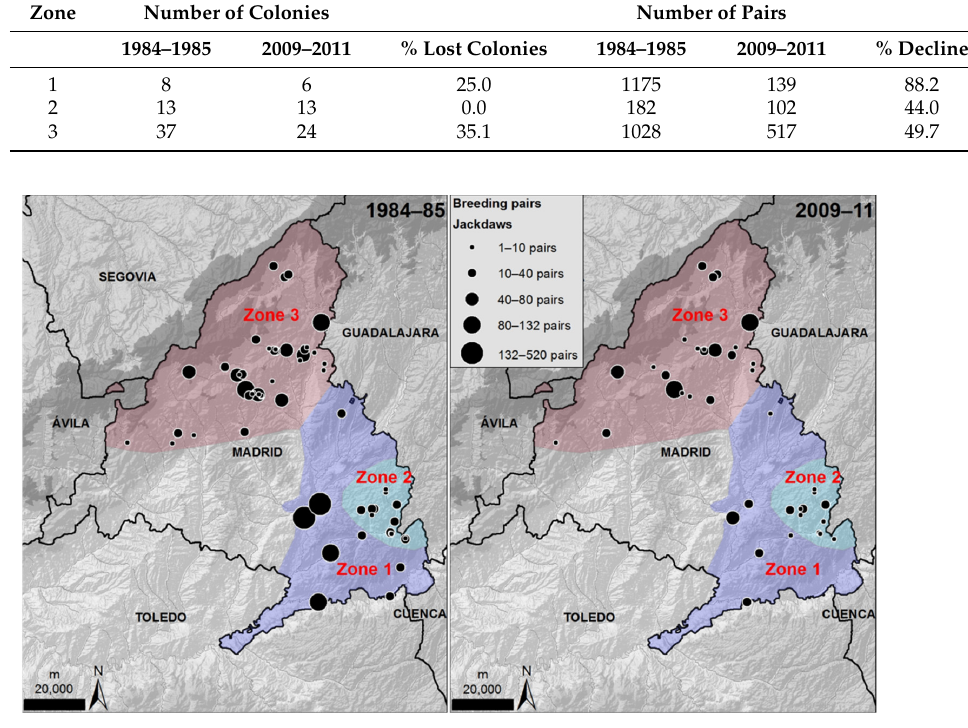
Figure 4. Location of colonies and number of breeding pairs of jackdaws censused in 1984–85 ( left panel) according to Domínguez [61] and re-censused in 2009–11 ( right panel, this study). Zone refers to the geographical areas specified in Figure 1.